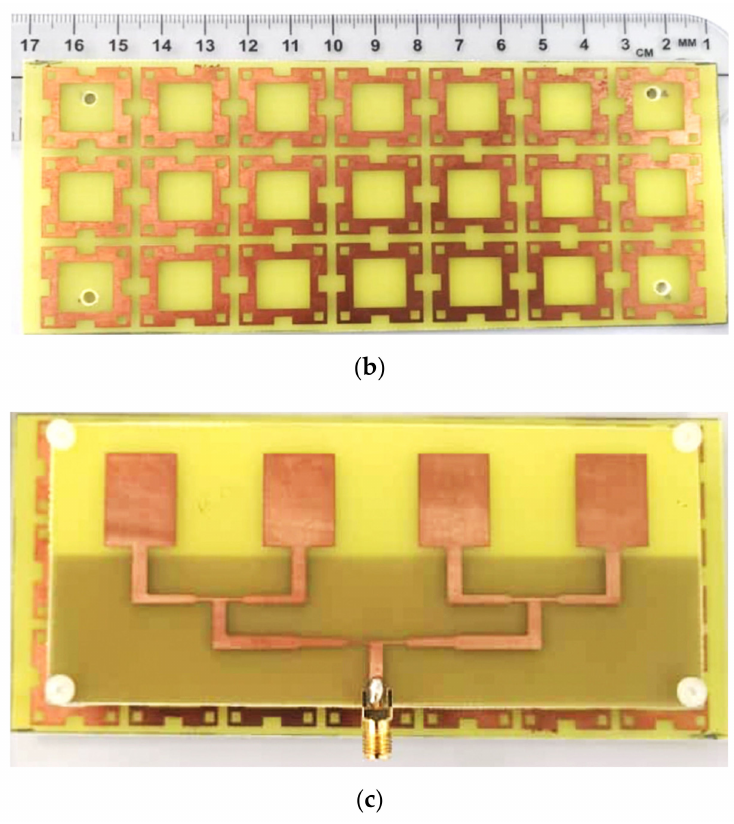
Figure 11. Photograph of the wideband array antenna with the measurement setup: ( a ) prototype of the 1 × 4 array antenna, ( b ) prototype of the 3 × 7 FSS reflector, and ( c ) integration of the array antenna with the FSS reflector.